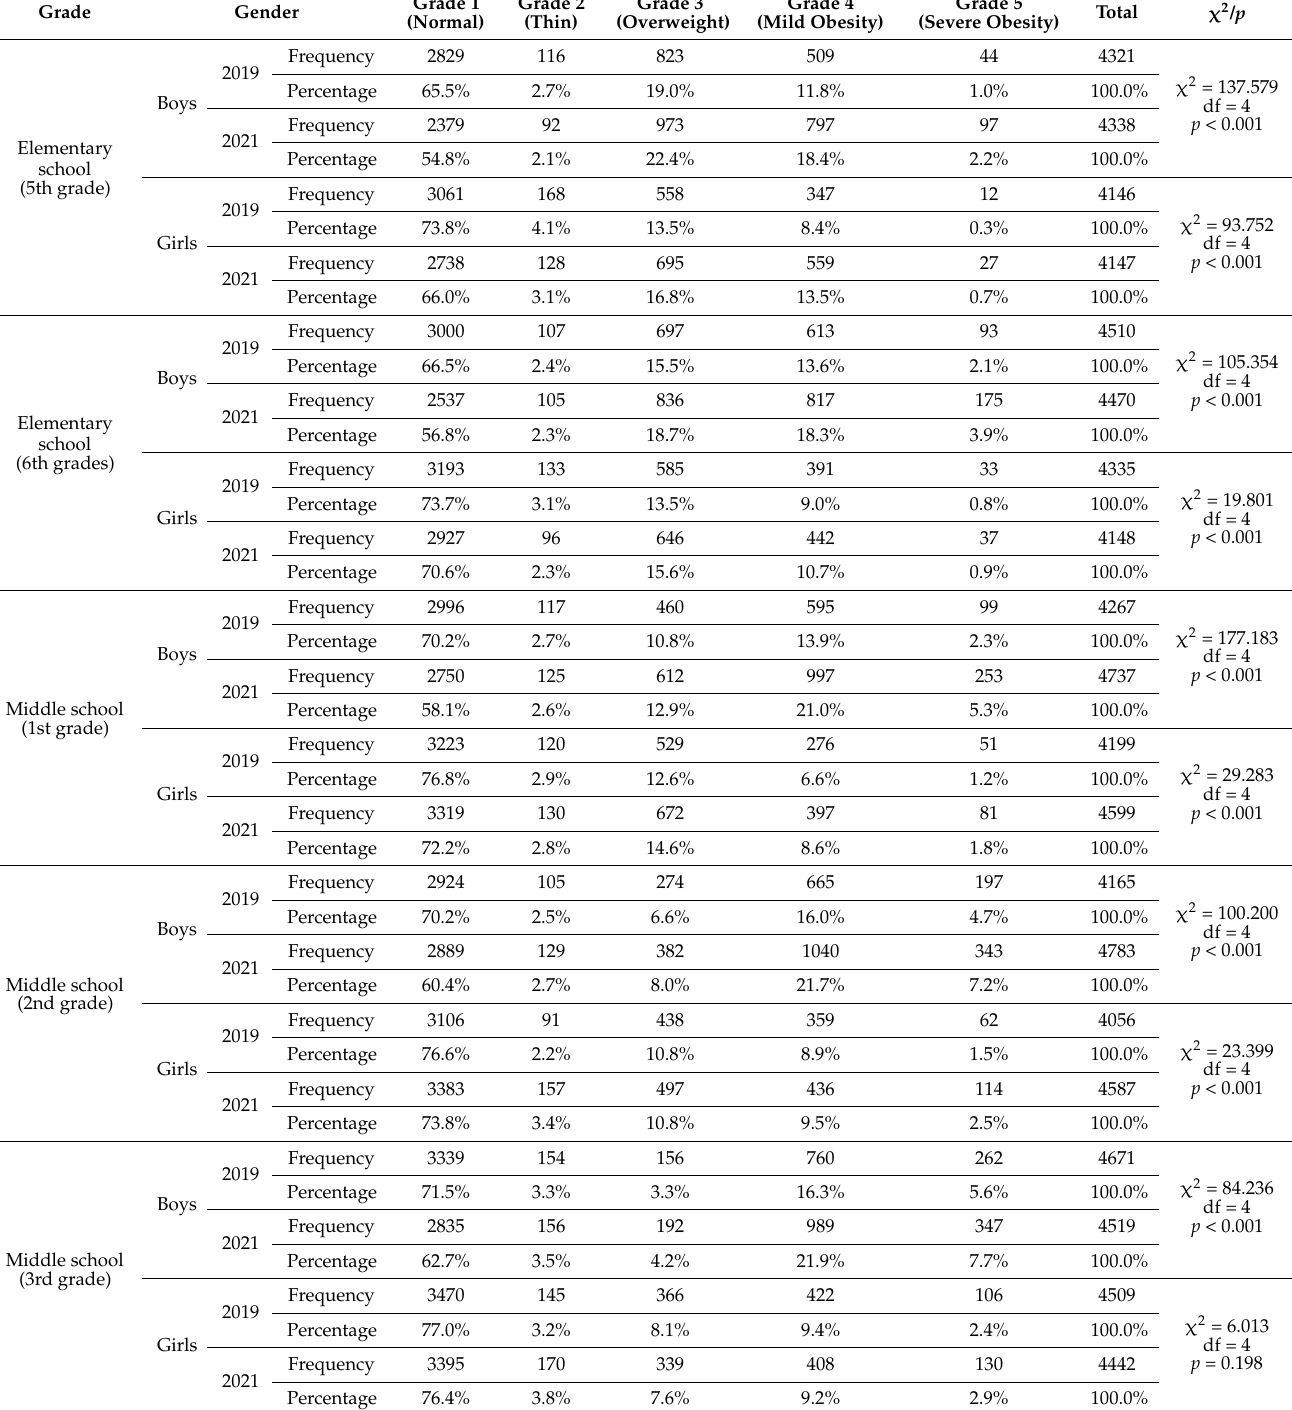
Table 7. Comparison of obesity status in 2019 and